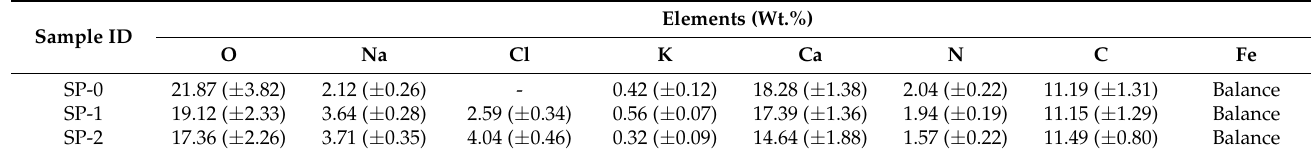
Table 5. EDS analysis of passive film.